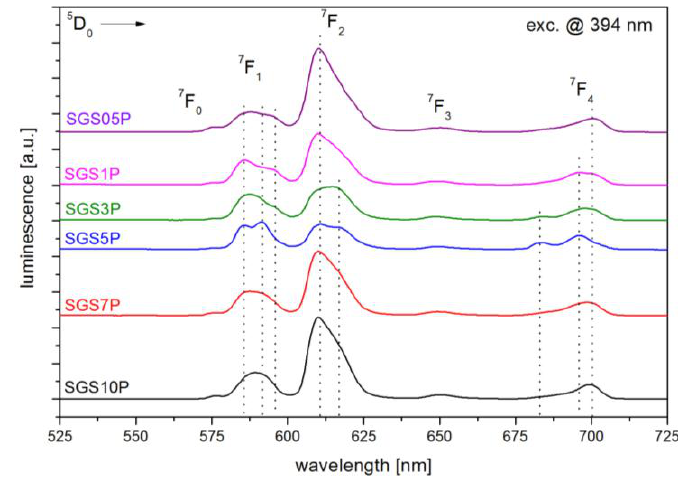
Figure 2. The luminescence spectra of SGSxP glasses doped with 0.5 mol % Eu 2 O 3 .